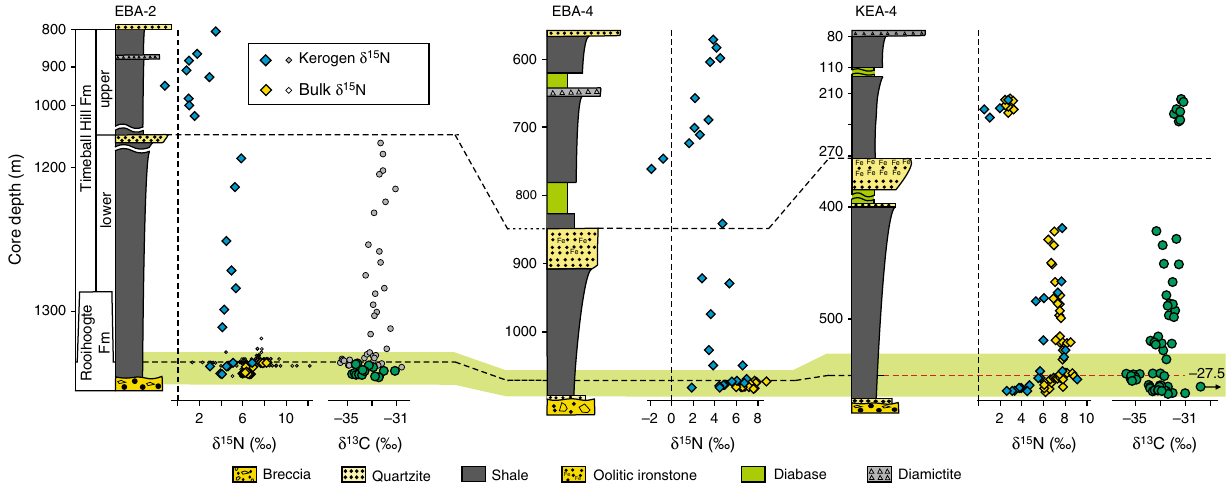
Fig. 3 Nitrogen and carbon isotope pro fi les spanning the upper Rooihoogte to upper Timeball Hill formations. Nitrogen and carbon isotopic data are reported relative to atmospheric N 2 and VPDB, respectively. Note the differential vertical scale between the lower and upper Timeball Hill Formation in cores KEA-4 and EBA-2. Only the lower part of the upper Timeball Hill Formation in core KEA-4 was analysed in this study. The smaller symbols are data from Zerkle et al. 14 The light green band represents the GOE interval identi fi ed by Luo et al. 20